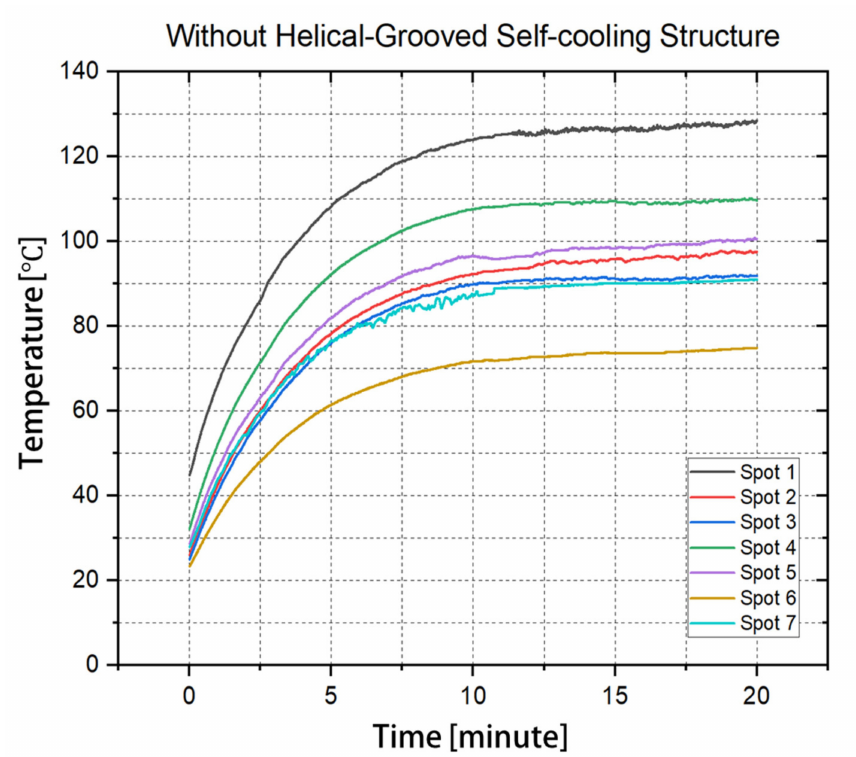
Figure 11. Heat dissipation experimental results of motor B. The temperature distribution of the motor for each spot was 77.2–97.4 ◦ C for motor A, and 73.6–125.6 ◦ C for motor B when the temperature was saturated, and a particular temperature range was reached. It was found that the temperature of motor B, where the cooling oil circulated and dissipated the generated heat, was 28.2 ◦ C lower than that